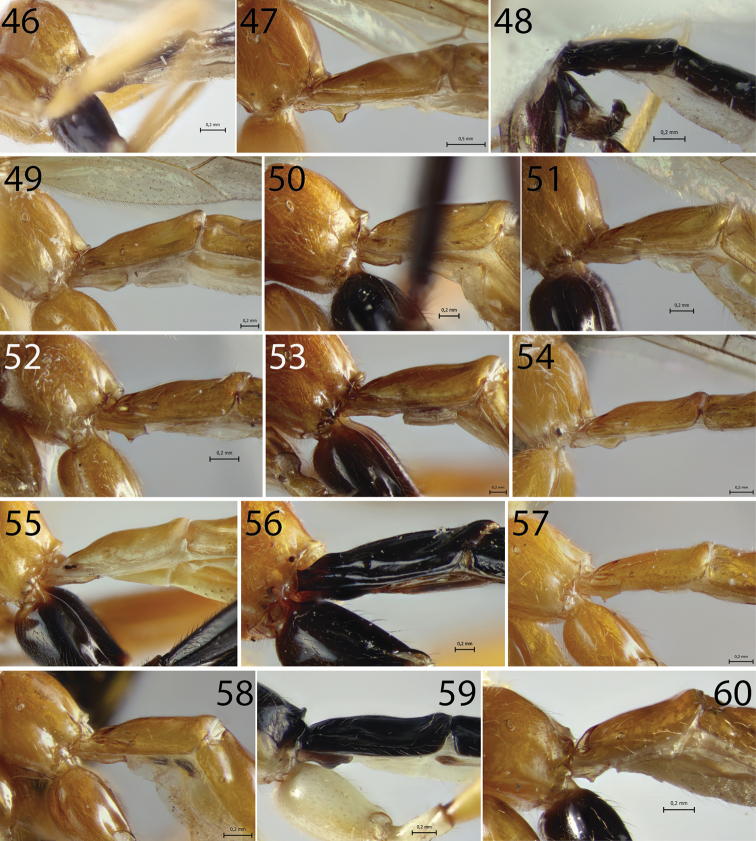
Sternite I of Hymenoepimecis spp. (females), lateral view 46H.
andina sp. nov. (holotype) 47H.
bicolor48H.
castilloi sp. nov. (holotype) 49H.
dolichocarinata sp. nov. (holotype) 50H.
duckensis51H.
ecuatoriana sp. nov. (holotype) 52H.
kleini53H.
longilobus sp. nov. (holotype) 54H.
manauara55H.
neotropica56H.
pucallpina sp. nov. (holotype) 57H.
rafaelmartinezi sp. nov. (holotype) 58H.
ribeiroi59H.
tedfordi60H.
uberensis.